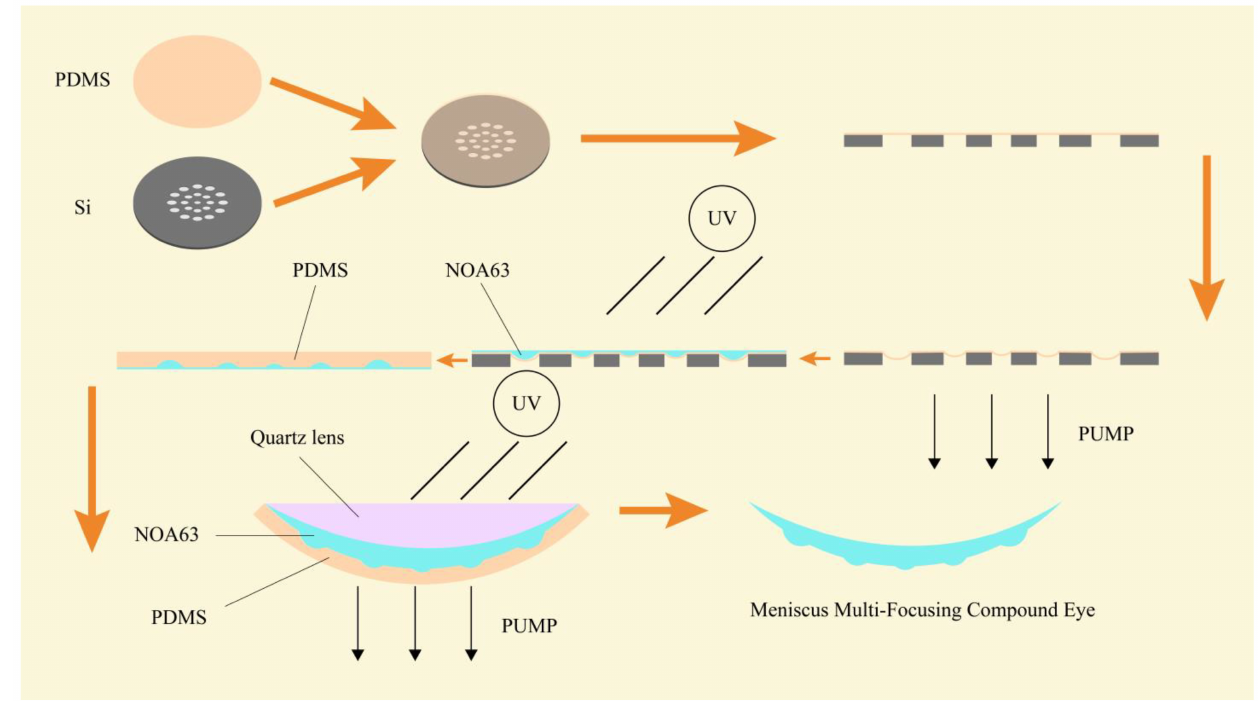
Figure 5. Meniscus multifocusing compound eye lens preparation process.